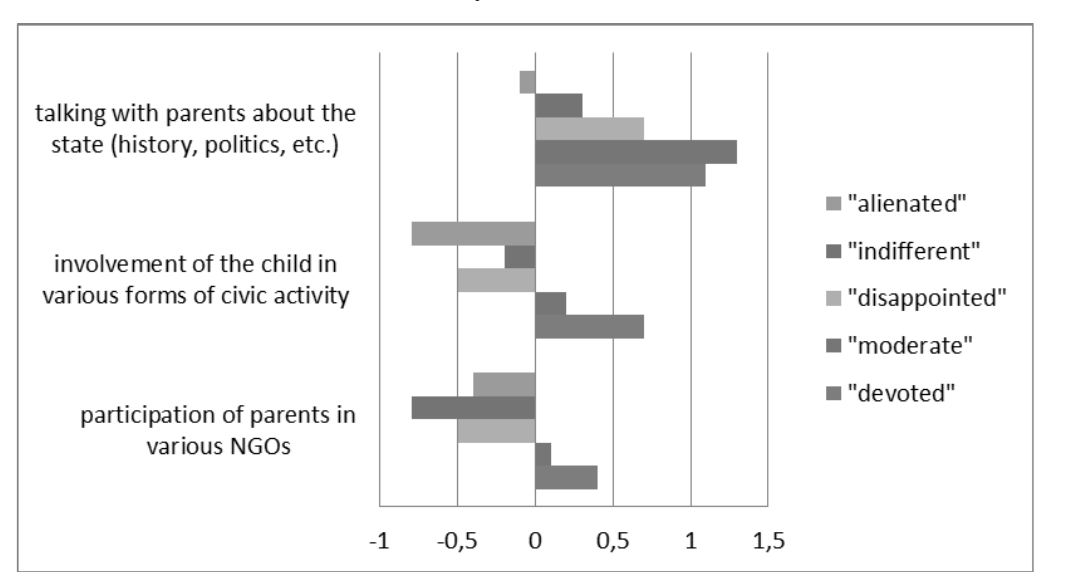
Civic behavioral patterns of reference persons of citizens with various types of civic identity Source: Own